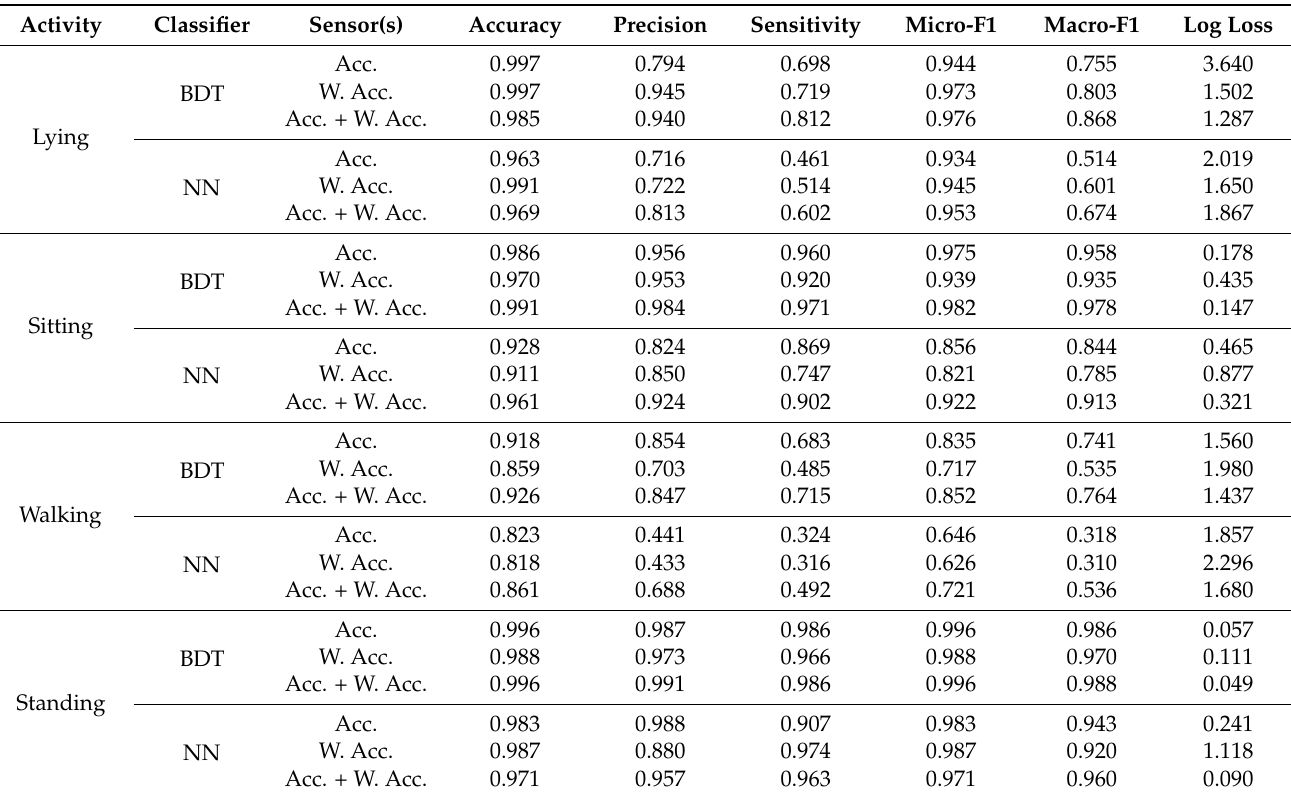
Table 5. Average results for behavioral context recognition (BCR) based on four physical